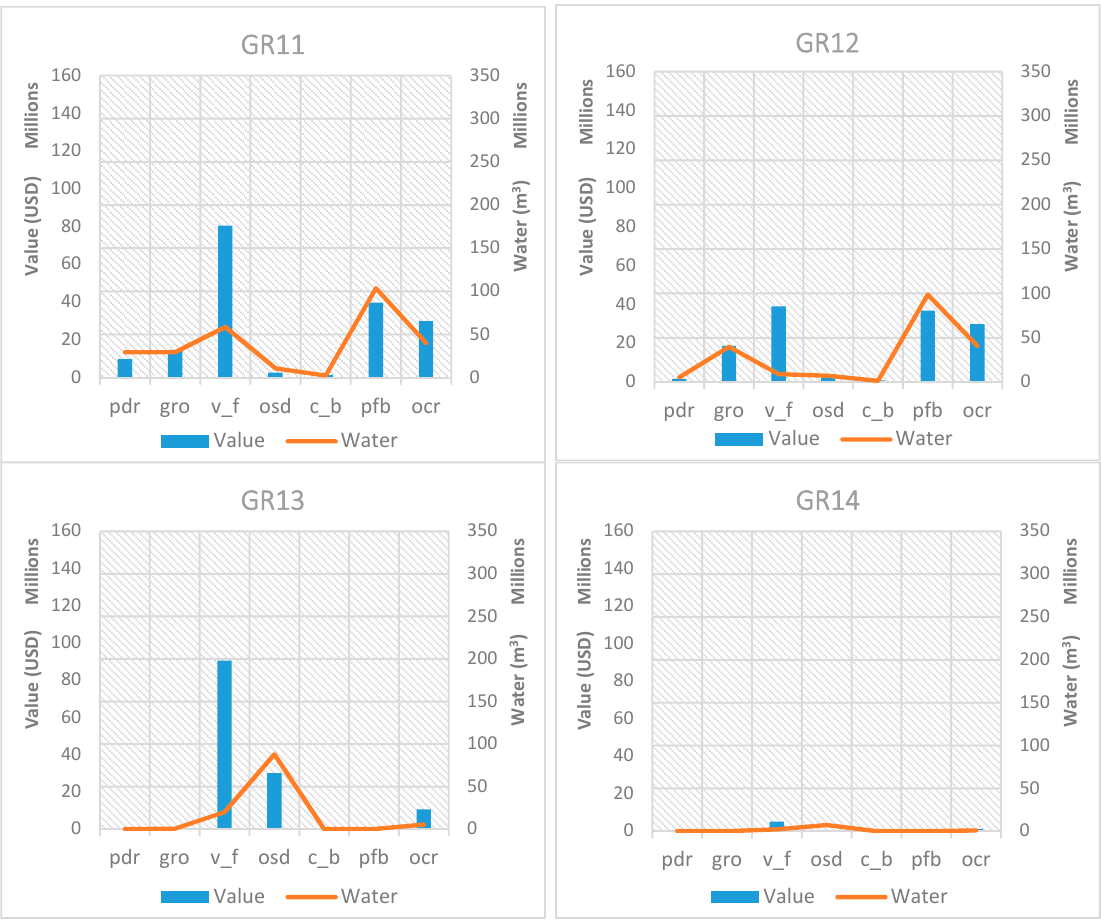
Figure 5. Exported crop values in comparison with the corresponding virtual crop water for all RBDs in Greece for the base year 2011.